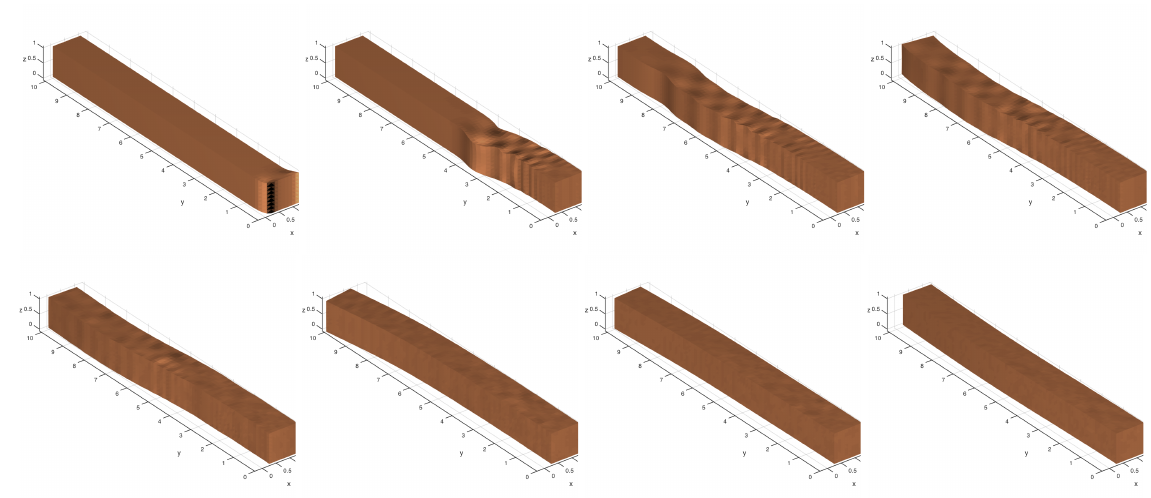
Fig. 9 Snapshots for the 3D simulation showing the norm of the stress. From left to right, then from top to bottom, time-step = 9, 30, 55, 70, 100, 200, 350, 500.